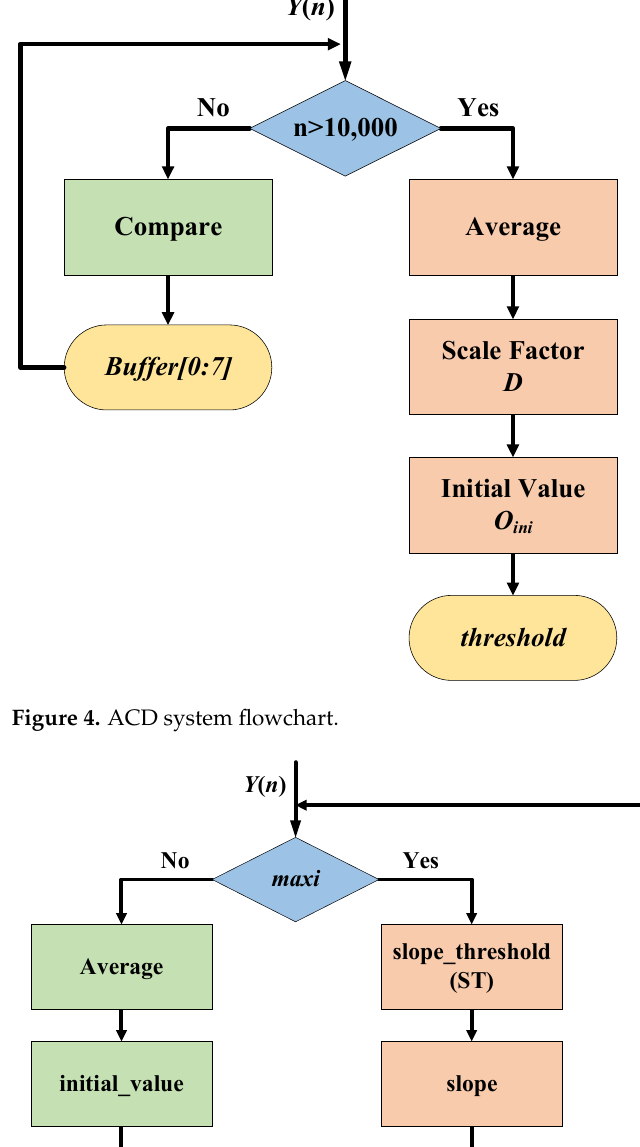
Figure 5. ASM S & C system flowchart.